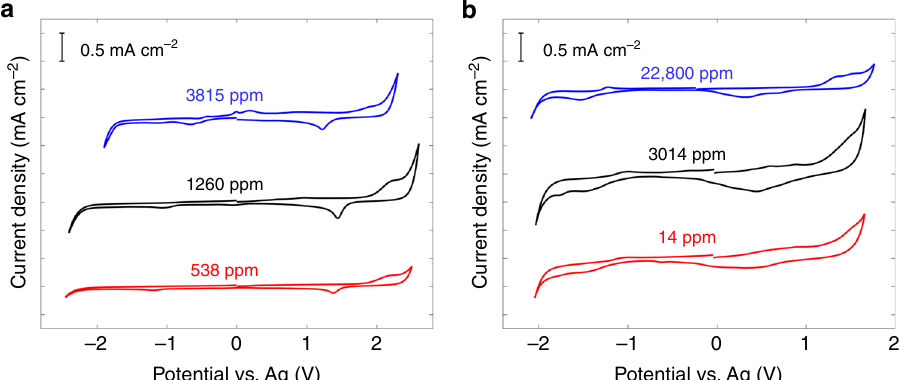
Fig. 3 Effects of water electrosorption on electrochemical activity on gold electrode. a , b Cyclic voltammograms of Au(111) in hydrophobic 1-butyl-1- methylpyrrolidinium bis(tri fl uoromethylsulfonyl)imide ([pyr14][TFSI]) ( a ) and hydrophilic 1-butyl-3-methylimidazolium tetra fl uoroborate ([BMIM][BF 4 ]) ( b ) under different water contents. Scan rate: 100 mV s −